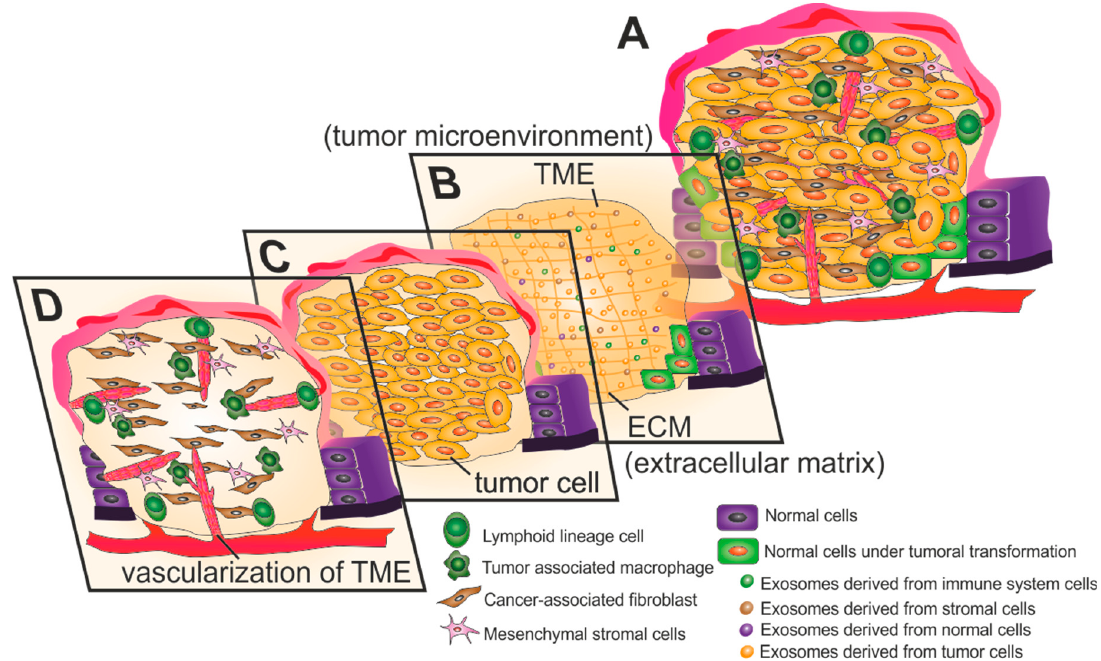
Figure 1. Anatomy of the tumor microenvironment (TME). ( A ) The TME of a late stage solid tumor is highly heterogeneous and complex. ( B ) Exosomes play important roles in paracrine and autocrine communication between TME cells, being preponderant in the modulation and development of the tumor. Exosomes are also involved in the transformation of normal cells adjacent to the TME into tumor cells. The extracellular matrix (ECM) in the TME is frequently dense and stiff, resulting in desmoplasia. ( C ) The rapid growth of tumor cells results in hypoxic regions and lack of nutrients within the tumor, causing the Warburg effect. This metabolic shift into anaerobic glycolytic pathway results in acidification of the TME. ( D ) The rapid growth of tumor cells induces angiogenesis and consequent formation of chaotic branching structures. Stromal cells (including Cancer-associated fibroblasts and mesenchymal stromal cells) and cells from the immune system (both lymphoid and myeloid lineage cells) are important players in tumor development and prognosis.